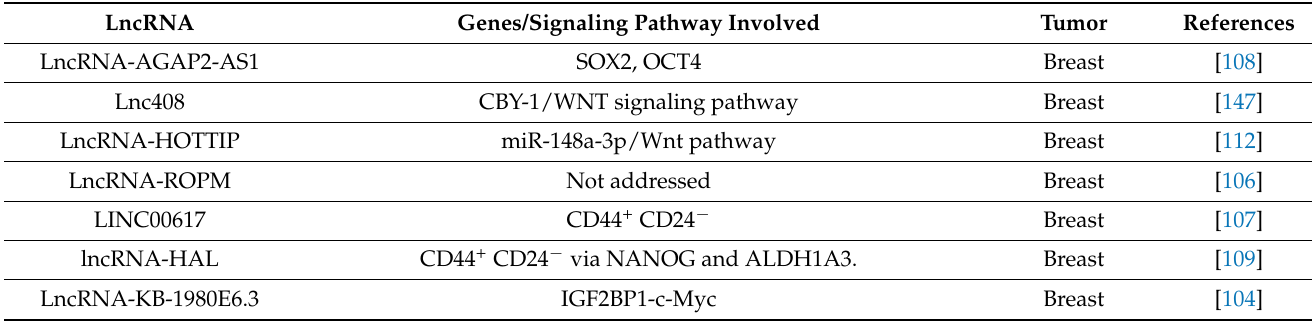
Table 2. LncRNAs that regulate the stem phenotype in the most common